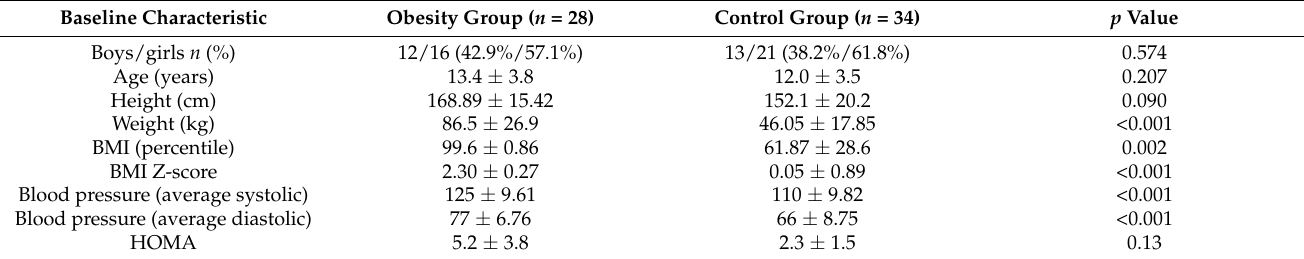
Table 1. The characteristics of the study group. Values are presented as mean ± standard deviation. Baseline Characteristic